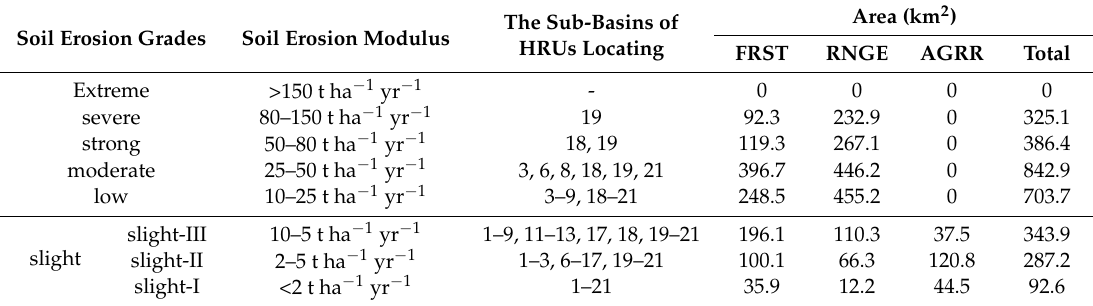
Table 6. The distribution of different erosion grades of HRUs in sub-basins under Scenario